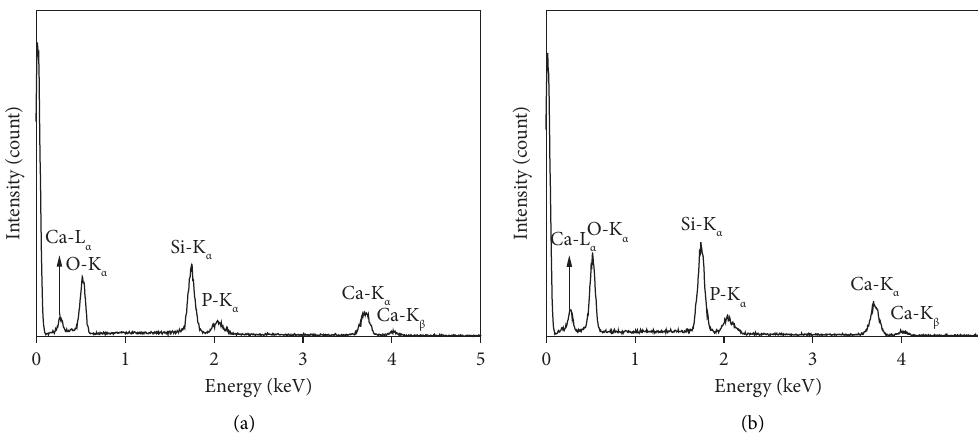
Figure 3: EDS spectra of (a) pure BG powder and (b) PEG-derived BG powder.